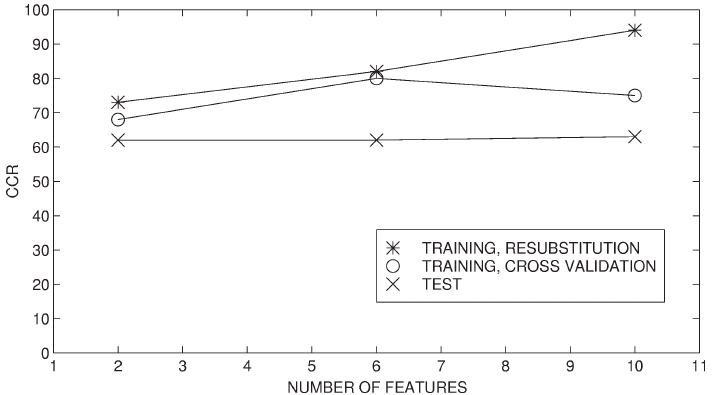
Fig. 4. Estimated classification result as a function of the number of features used in the classification rule selected from the smaller feature set of 28 features. The resubstitution estimate from the training data is highly over-optimistic and increases with the number of features used. The cross-validation estimate is also highly over-optimistic and increases with the number of features used. Testing the classification rules on the independent test data revealed CCRs of about 60%, which are useless results since only few patients with relapse were correctly classified. CCR, correct classification